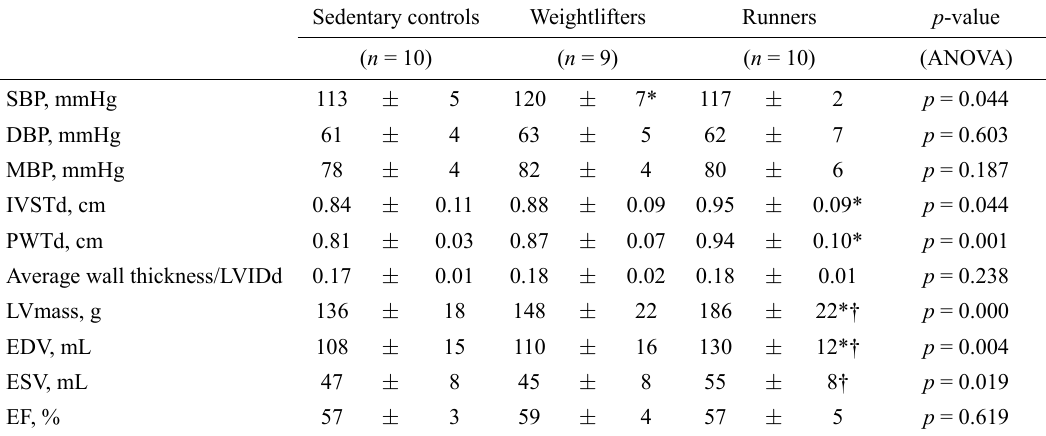
Table 2. Baseline cardiovascular structure and